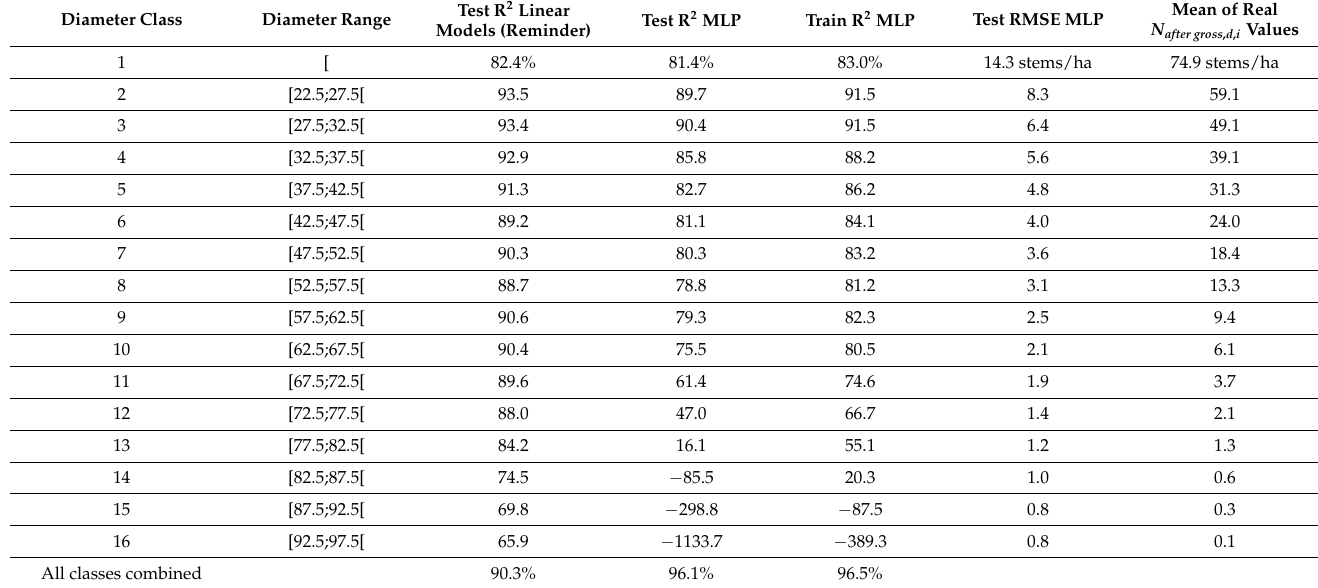
Table 3. Comparison of performances for predicting N after gross , d , i between the linear models and the multilayer perceptron